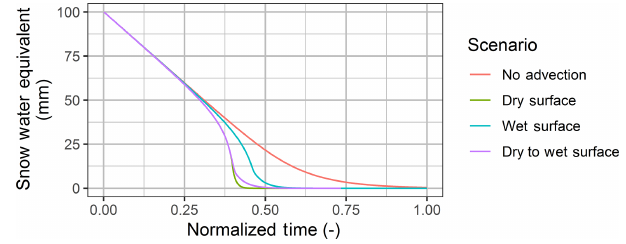
Figure 8. Modelled snow water equivalent depletion for various ad- vection scenarios.